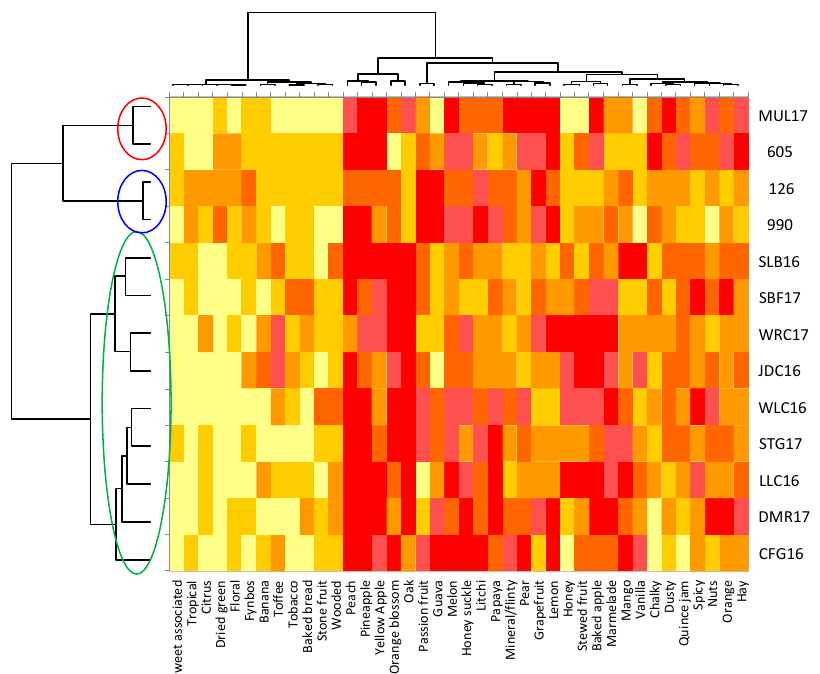
Figure 6. Heatmap associated with the results of the CATA task for the Chenin Blanc wines evaluated. The dendrogram on the left corresponds to the Hierarchical Cluster Analysis on the CATA results. Wine codes as indicated in the text.